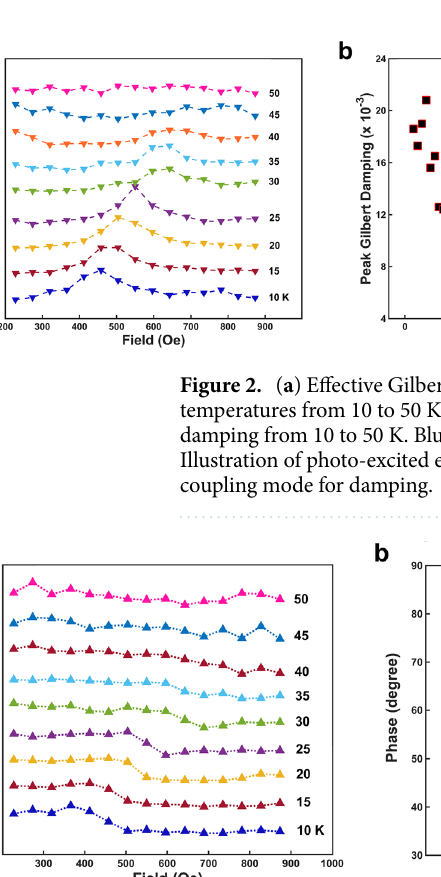
Figure 3. Phase of magnetization precession as a function of externally applied field at different temperatures from 10 to 50 K ( a ), and zoomed specifically at 10 K ( b ). ( c ) TRMOKE data as a function of normalized precession phase under different applied fields. The red straight line is a guideline of the phase